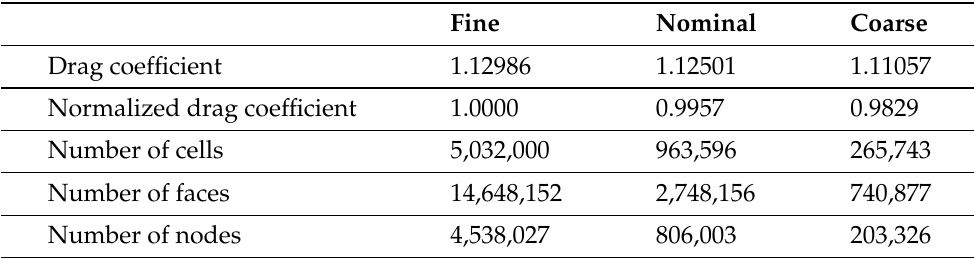
Figure 5. Pressure coefficient distribution on the symmetry plane with different computational grids. Table 1. Comparison of drag coefficient and the number of computational cells, faces, and nodes with different computational